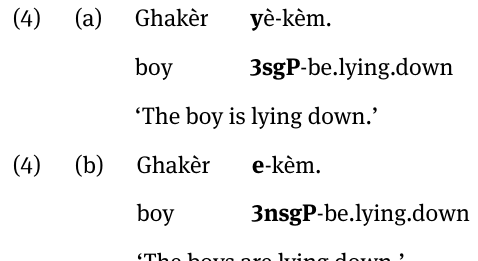
Table 1: Differences between the Nama verb types argument(s) indexed agent patient transitive √ √ agentive intransitive √ patientive intransitive